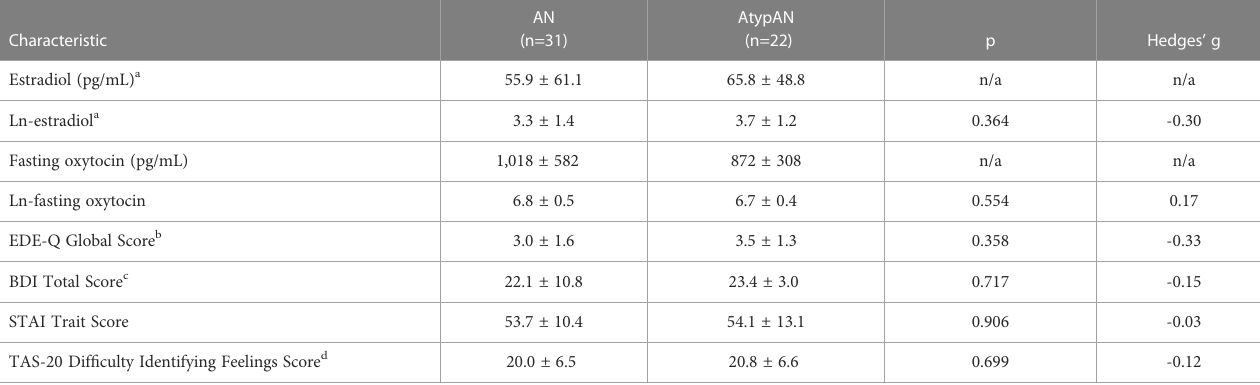
TABLE 1 Participant characteristics of hormone levels and key psychopathology endpoints for women with anorexia nervosa (AN) versus atypical AN (AtypAN).